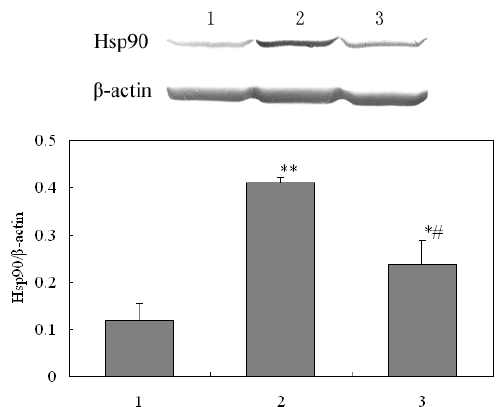
Figure 5. Western blot image of Hsp90 expression and β -actin (loading control) protein expression. The expression of Hsp90 in each sample from three groups is internally normalized to β -actin and the values are presented underneath the image. ( 1 ) Normal group; ( 2 ) Model group; and ( 3 ) 5'-AMP-treated group. ** p < 0.01, * p < 0.05 vs.